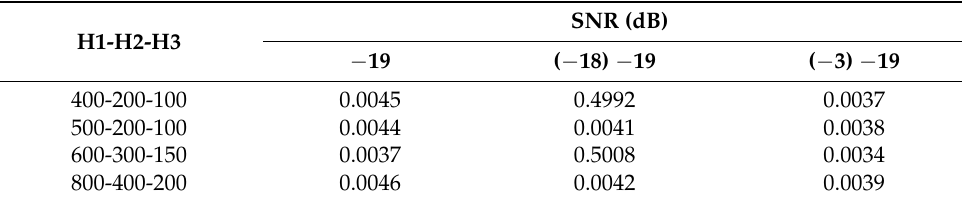
Table 2. SER comparison based on three hidden layers in the stacked DSAE